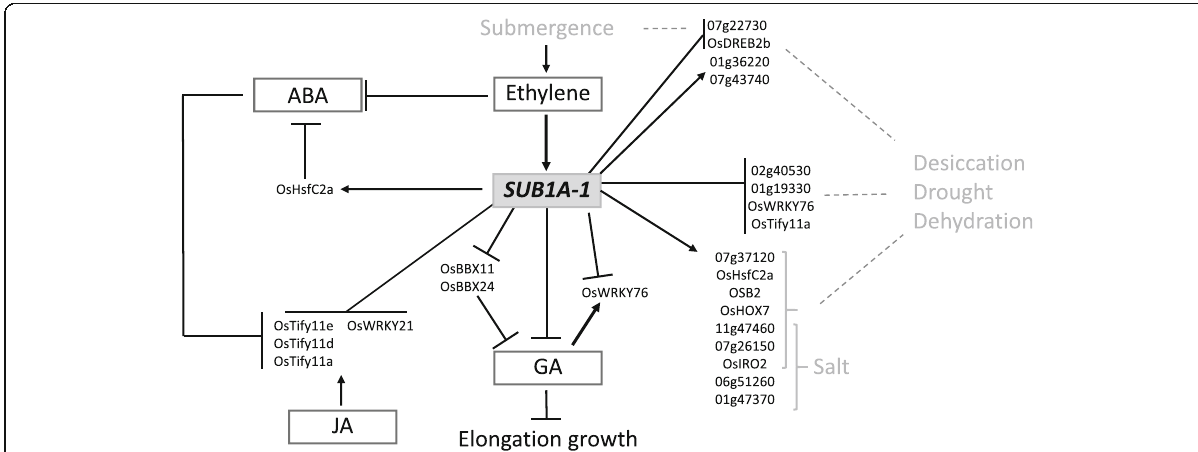
Fig. 3 Differentially expressed transcription factor genes in IR64-Sub1. An overview of the transcription factor genes and their related pathways is provided for all genes that are specifically submergence-responsive in IR64-Sub1 which carries the SUB1A-1 allele. The figure is based on a literature review, see text for